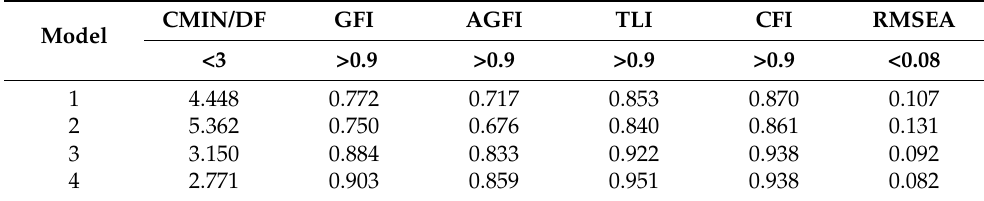
Table 5. Fitness of the model for AAAQ.